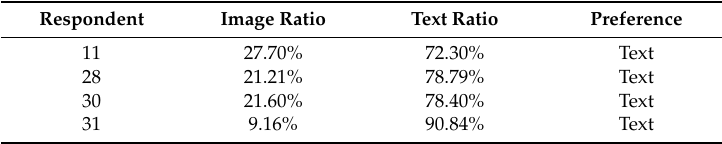
Table 13. Respondents with severe